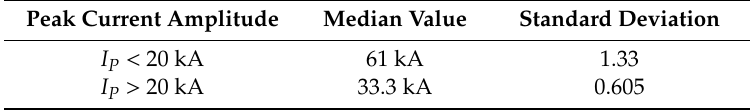
Table 3. Statistical distribution of the first negative return stroke peak